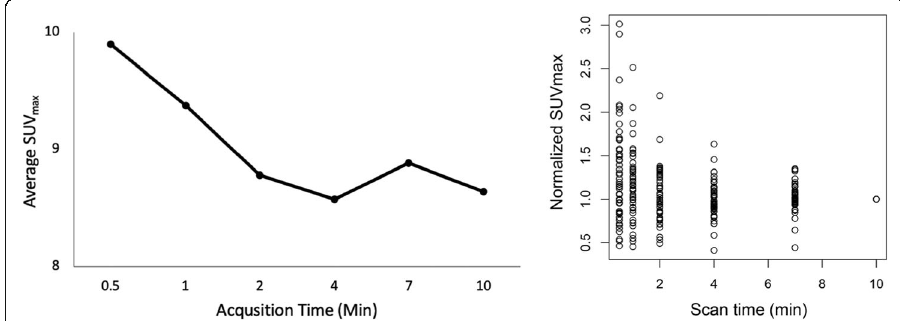
Fig. 4 As acquisition time increased, average SUV max decreased from 9.89±6.62 for 0.5min to 8.64±6.81 for 10 min and was lowest at an acquisition time of 4min per bed position (left). On average, the SUV max normalized to the 10min value decreased from 1.05±0.29 at 2min to 1.00 at 10min of scan time (right, p